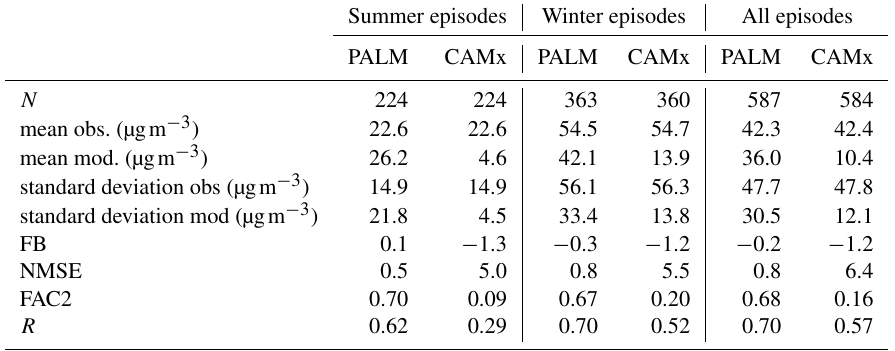
Table 6. Comparison of 1h average NO x concentrations measured in the street canyons with CAMx and PALM results for the same location.